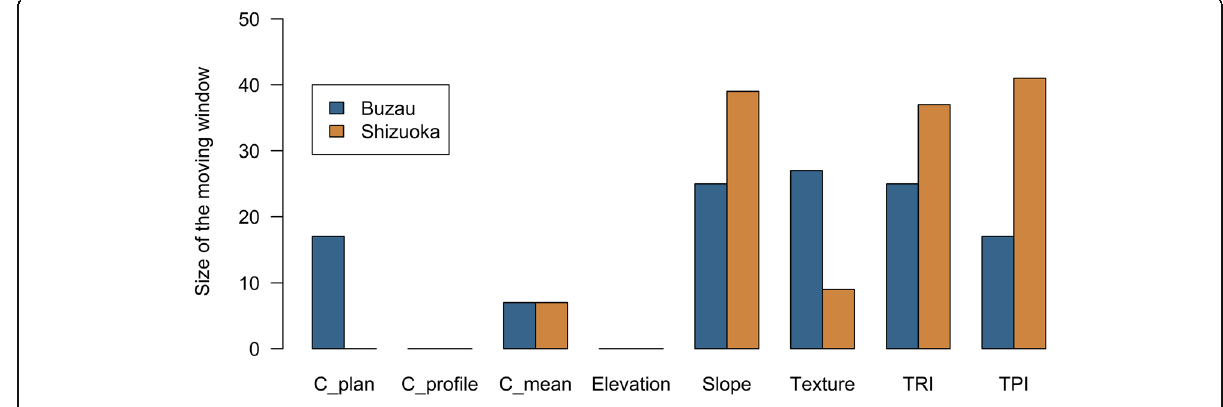
Fig. 5 Size of the moving window at which each LSV predicts best the landslide